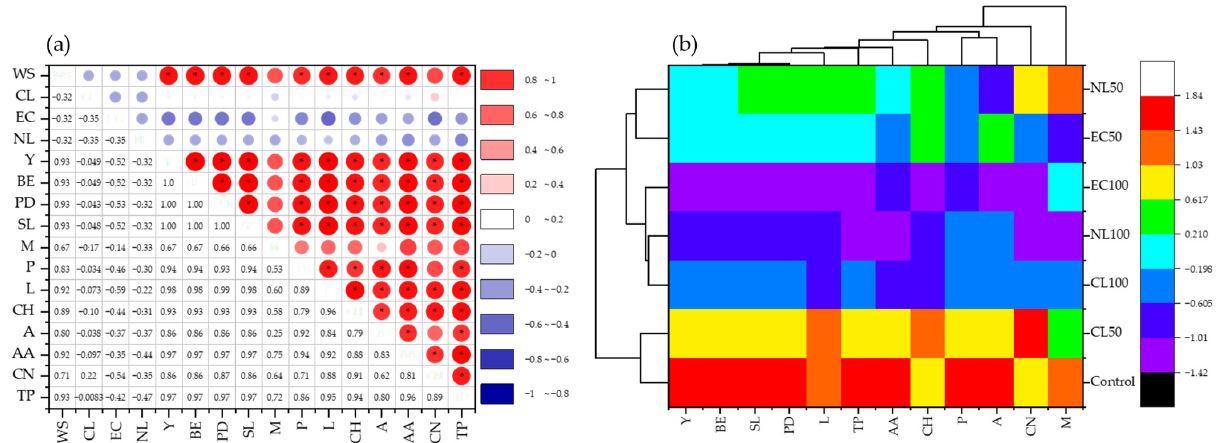
Figure 3. ( a ) Pearson correlation and ( b ) hierarchal cluster matrices showing the effect of different biomass treatments on growth, yield, and biochemical constituents of P. florida (TL: Typha latifolia ; EC: Eichhornia crassipes ; NL: Nelumbo nucifera ; WS: wheat straw; Y: yield; BE: biological efficiency; PD: pileus diameter; SL: stipe length; M: moisture; P: protein; L: lipid; CH: carbohydrates; A: ash; AA: ascorbic acid; CN: carotenoids; TP: total